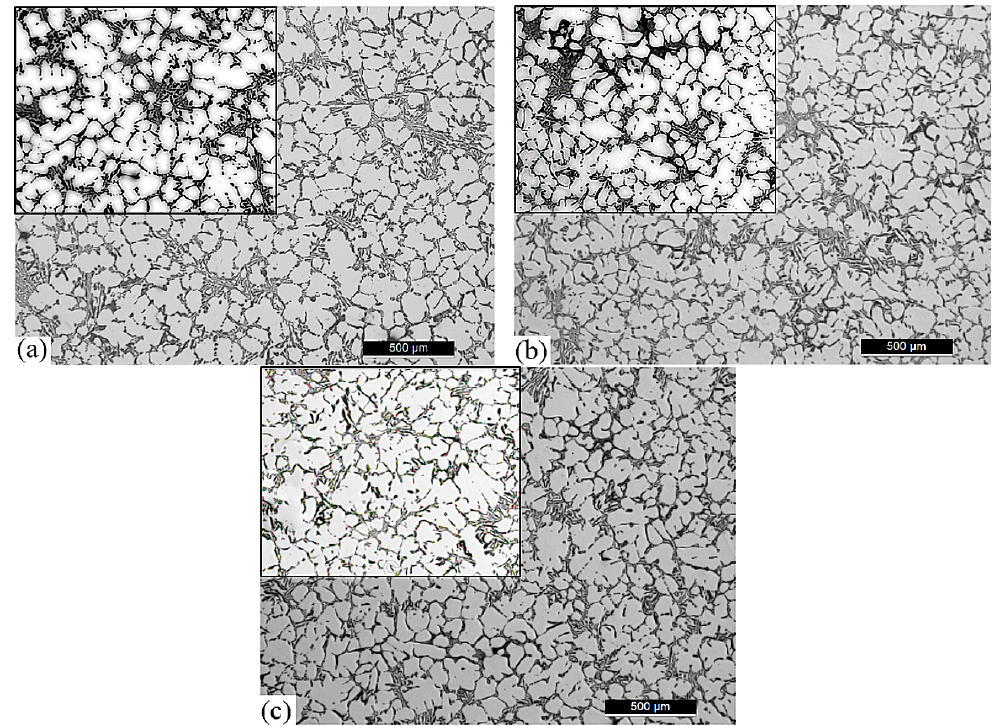
Figure 6. Examples of microstructures of AlSi7Mg0.3 alloy processed by ultrasound, at 19.9 ± 0.2 kHz average frequency evaluated in a horizontal section of the feeder: ( a ) H#1, ( b ) H#2 and ( c ) H#3 samples, according to Figure 1.